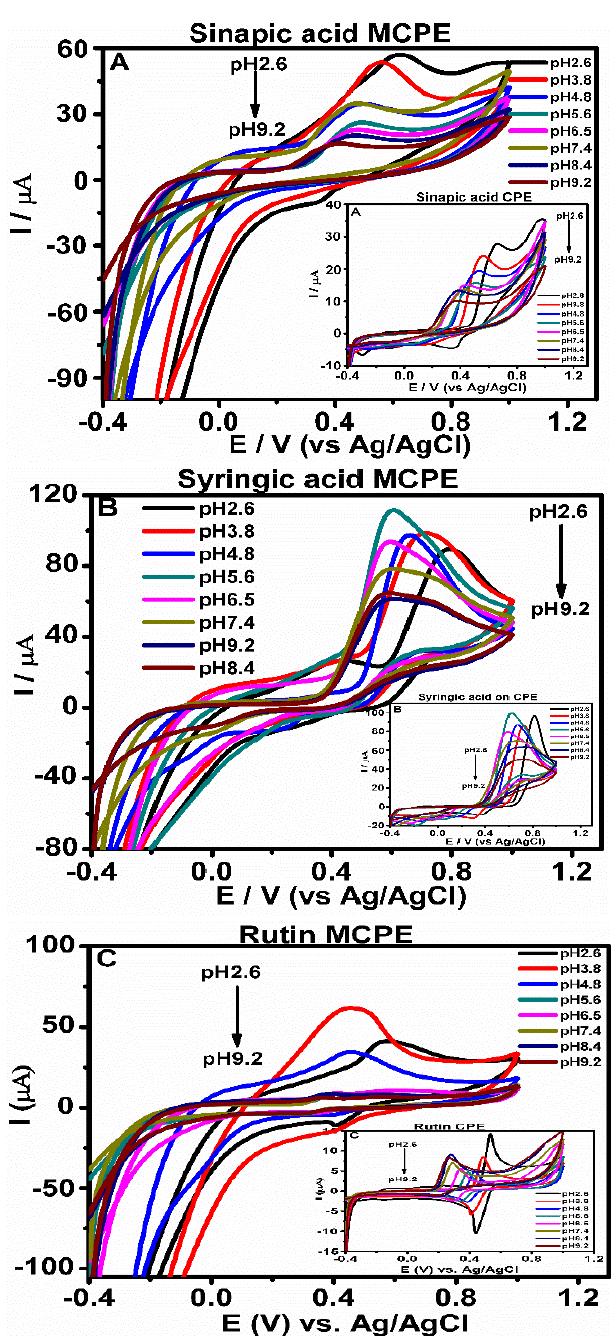
Figure 5. Cyclic voltammograms ( A – C ) show the effect of pH on the electrochemical behavior of the phenolic compounds, in 0.5 M acetate buffer of pH 2.6, 3.8, 4.8, 5.6, 6.5, 7.4, 8.4, and 9.2, at a scan rate of 0.2 V/s with a reversible scanning potential range of −0.4 to 1.0 V. The inset figures show cyclic voltammetry (CV) at CPE.